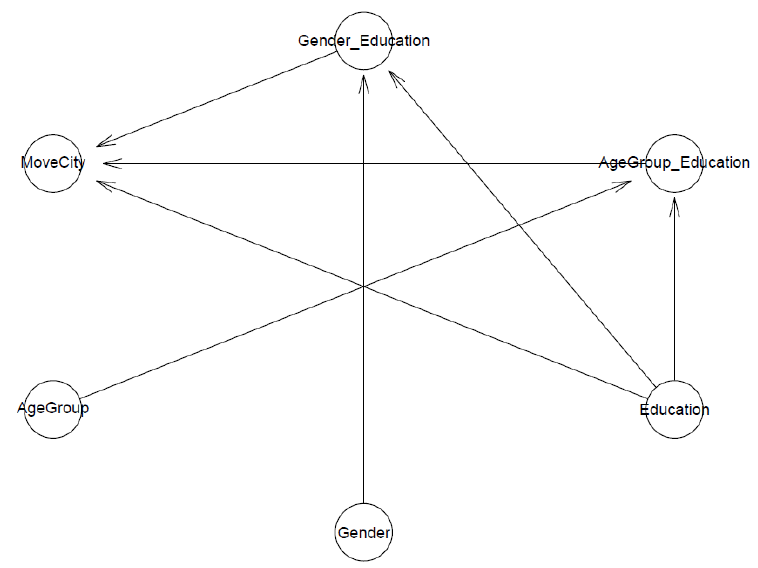
Figure 1. Model 1 (cid:48) s logical network. Figure 1. Model 1′s logical network. Figure 2 indicates that all k values are below the threshold of 0.5, so Model 1 has a high goodness-of-fit with the